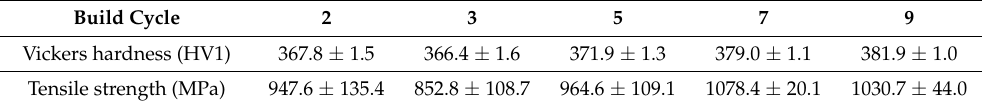
Table 3. Regression analysis of the mean hardness vs. oxygen level and tensile strength vs. oxygen level, respectively.